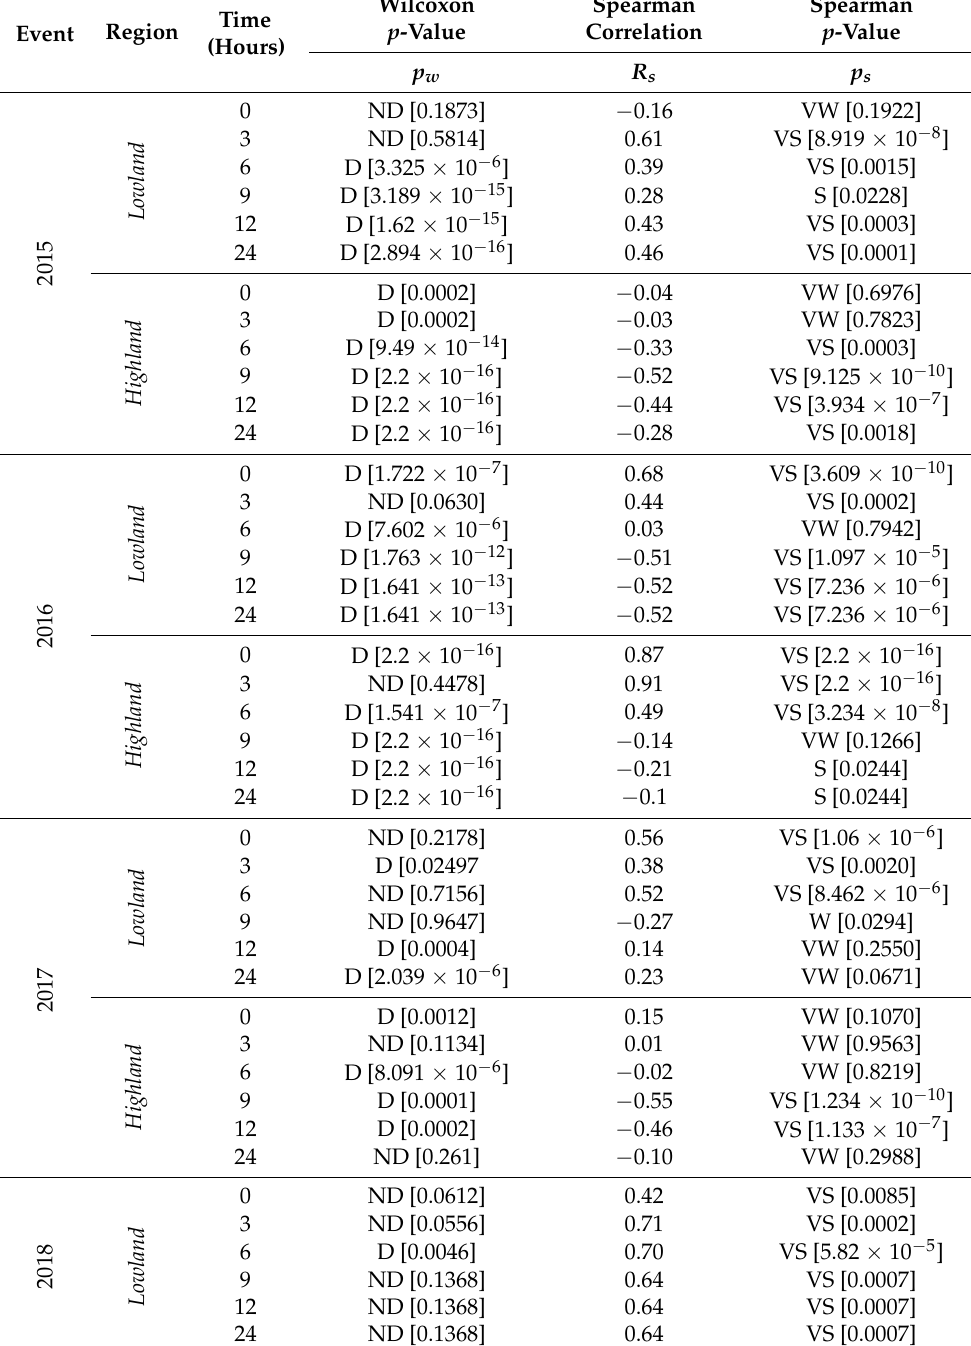
Table 2. Results of the statistical metrics for comparing TMPA and IMERG data over the highland and lowland regions at successive times of 0 h, 3 h, 6 h, 9 h, 12 h, and 24 h from the start of the rainfall event: (a) the Wilcoxon signed-rank tests ( p w , values p w < 0.05 are denoted as D, indicating a significant difference between the two sets, otherwise they are denoted as ND (No Difference), (b) the Spearman correlation coefficient ( R s ; negative values indicate a negative correlation), (c) the Spearman p -value range ( p s , where VS (Very Strong) denotes very strong evidence for rejecting the null hypothesis [ p s < 0.01], S strong evidence [0.01 ≤ p s < 0.05], W weak evidence [0.05 ≤ p s < 0.1], and VW (Very Weak) very weak evidence [ p s ≥